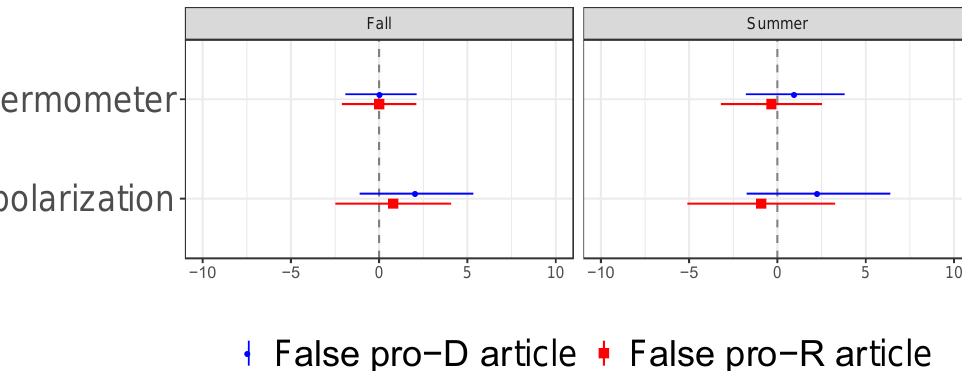
Figure 4a. Effect of false article exposure on attitudes and participation intentions: Media and party feelings. Effect of exposure to a false article from an untrustworthy website on media thermometer rating and affective polarization. Point estimates (with 95% confidence intervals) from separate OLS regressions. Outcome measures are respondent feelings toward the media on a 0 – 100 scale (media thermometer) and the difference in feelings respondents express toward their preferred party and the opposition party (both measured on a 0 – 100 scale). Control variables include partisanship, ideology, political knowledge, feelings toward President Trump, age, race, and college education. See Table B6 for full